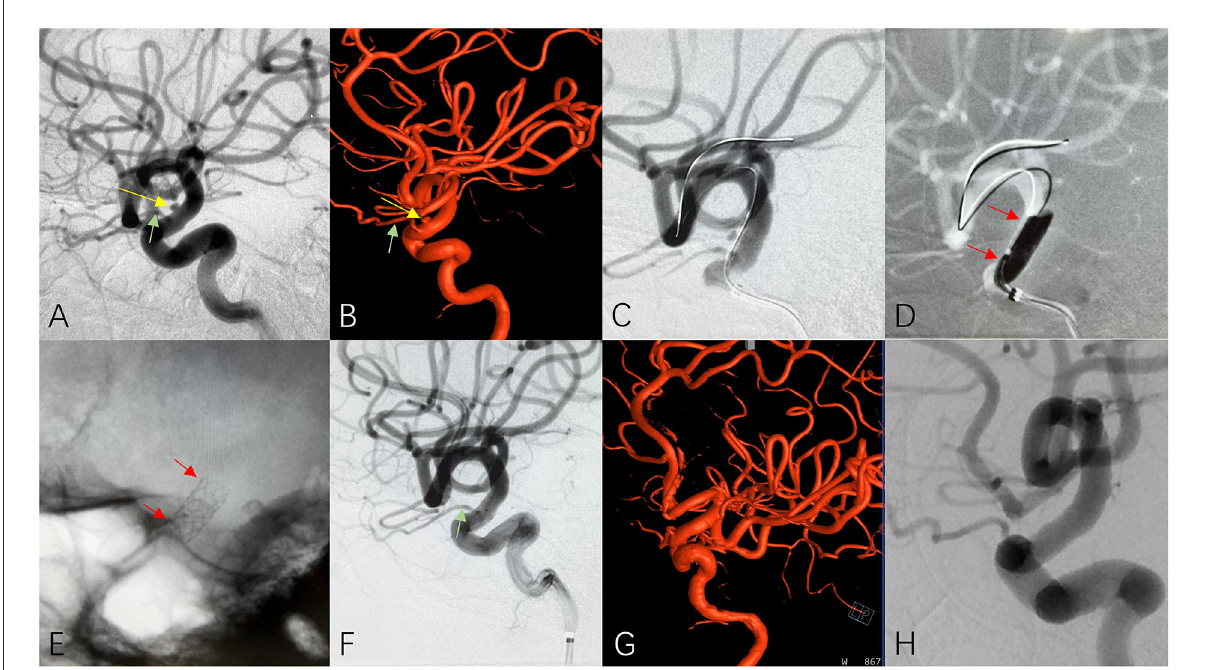
FIGURE2 A patient with cerebral aneurysm received covered stent insertion. 2D (A) and 3D (B) cerebral angiograms reveled a unruptured tiny cerebral aneurysm (yellow arrow) and adjacent ophthalmic artery (green arrow) at the C6 segment of ICA. A covered stent (3.5 × 10mm) was delivered ( C , red arrows) released at the diseased parent artery ( D , red arrows) and the plain film clearly showed well opened covered stent after deployment ( E , red arrows). Immediate 2D (F) , 3D (G) and 4-months follow up (H) cerebral angiogram confirmed complete disappearance of aneurysm and excellent patency of the ophthalmic artery (green arrow) and parent